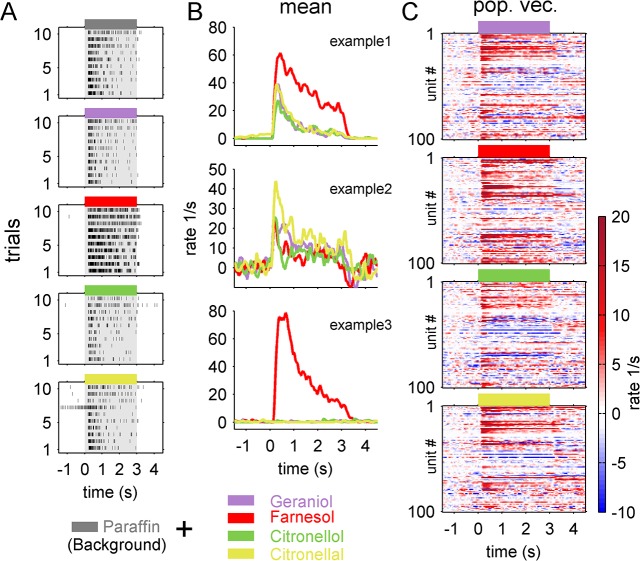
Experimental procedure and construction of population vector activity.(A) (example unit); trial resolved single unit activity in response to the different odor stimuli. Each tick mark refers to one action potential (spike). The colored bars on top of each spike raster plot indicates the three seconds of odor presentation (grey = Paraffin oil, used as solvent and background, violet = Geraniol, red = Farnesol, green = Citronellol, yellow = Citronellal; cp. legend below). The example unit is responding reliably to each single stimulation (trial). From the 10 trials we calculated the odor dependent average response rates for each single unit. (B) Averaged response rates of three example units (color code is given in the legend). Example1 is the unit shown in (A) responding to all of the presented odor stimuli, showing the highest and most prolonged amplitude to farnesol. Example2 also responded to all odors, but the highest response was evoked by citronellal. Example3 did not respond to any other tested odor, but to farnesol. (C) from the averaged response rate of all 100 AL-units the population vectors were constructed. Each single line refers to the averaged response rate out of the 10 trials for a single unit. Odor stimulation started at time zero and lasted three seconds. Response strength is indicated by the color bar.